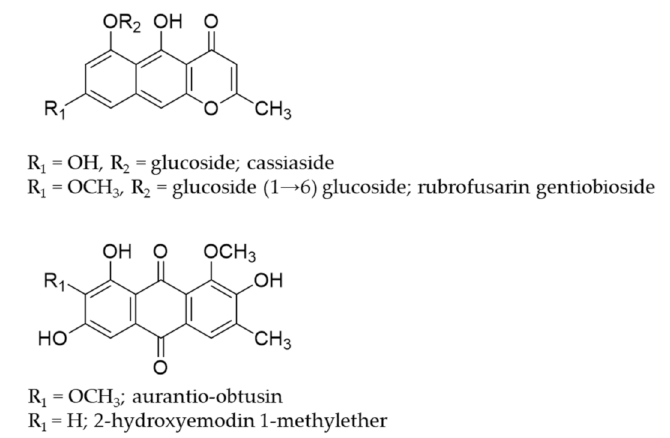
Figure 1. Structures of compounds isolated from Cassia seeds.